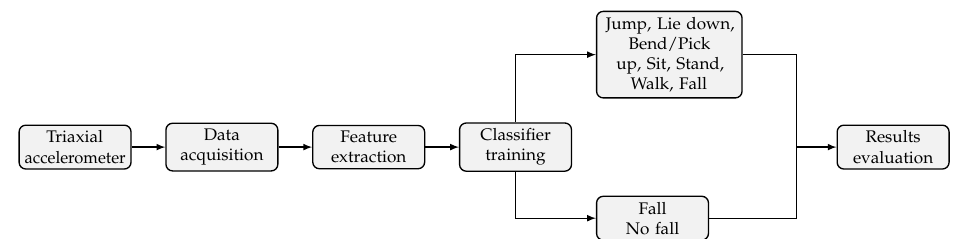
Figure 1. Overview of the proposed Fall and ADL detection methodology.